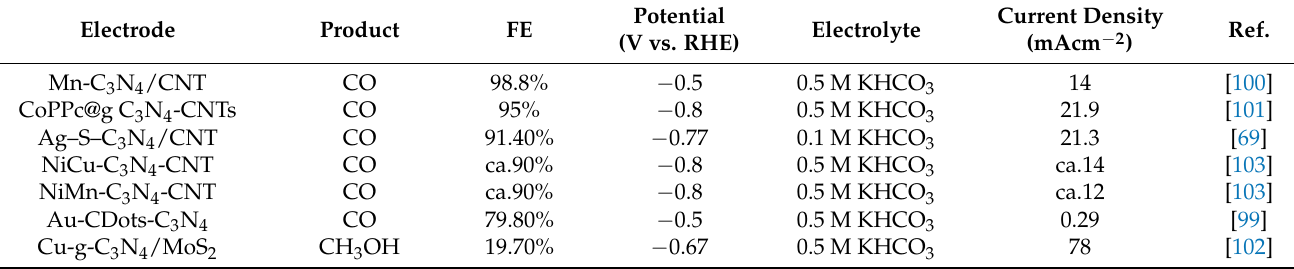
Table 6. Electrocatalytic parameters of the ternary composite catalysts on eCO 2